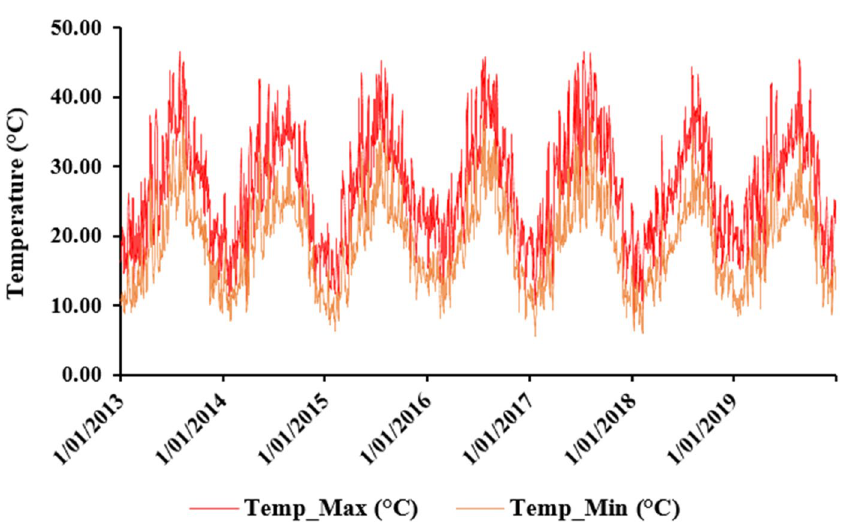
Figure 4. The evolution of maximum and minimum temperature over 7 years’ time horizon